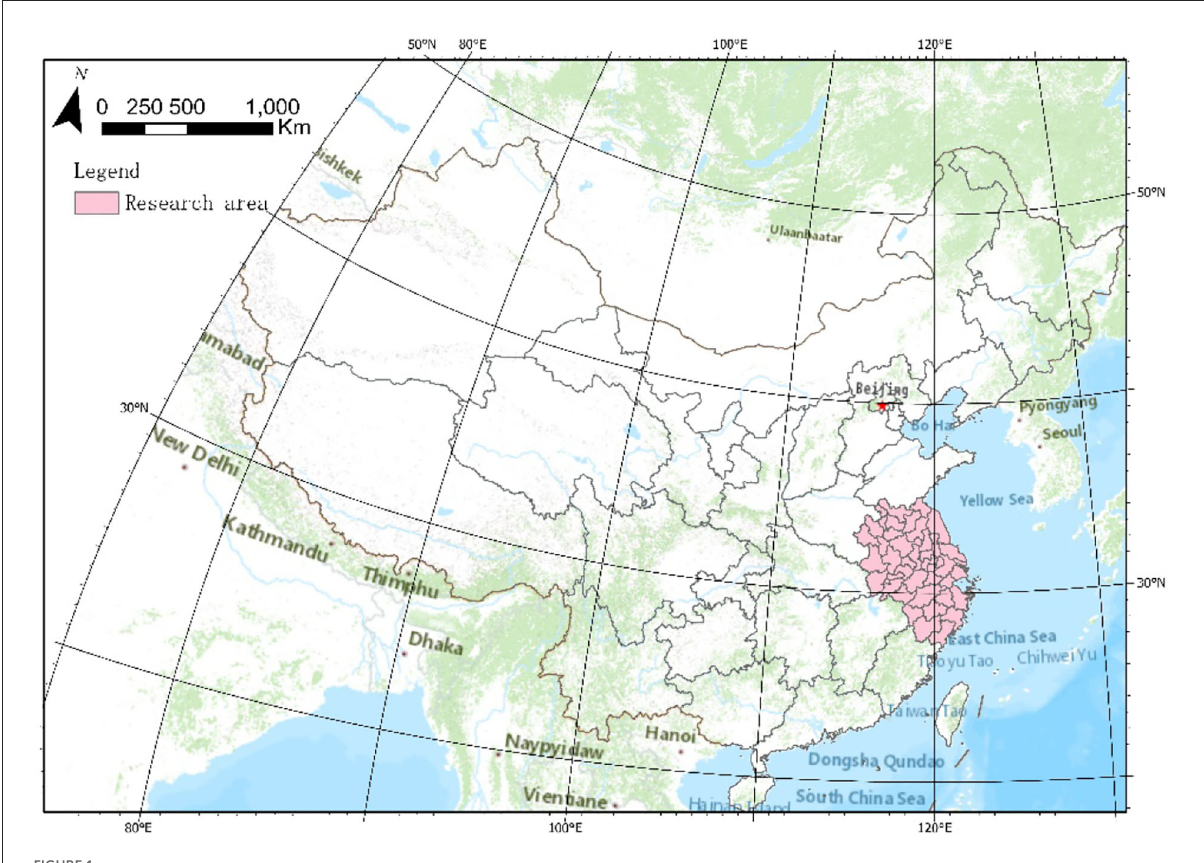
FIGURE1 The location of the Yangtze River